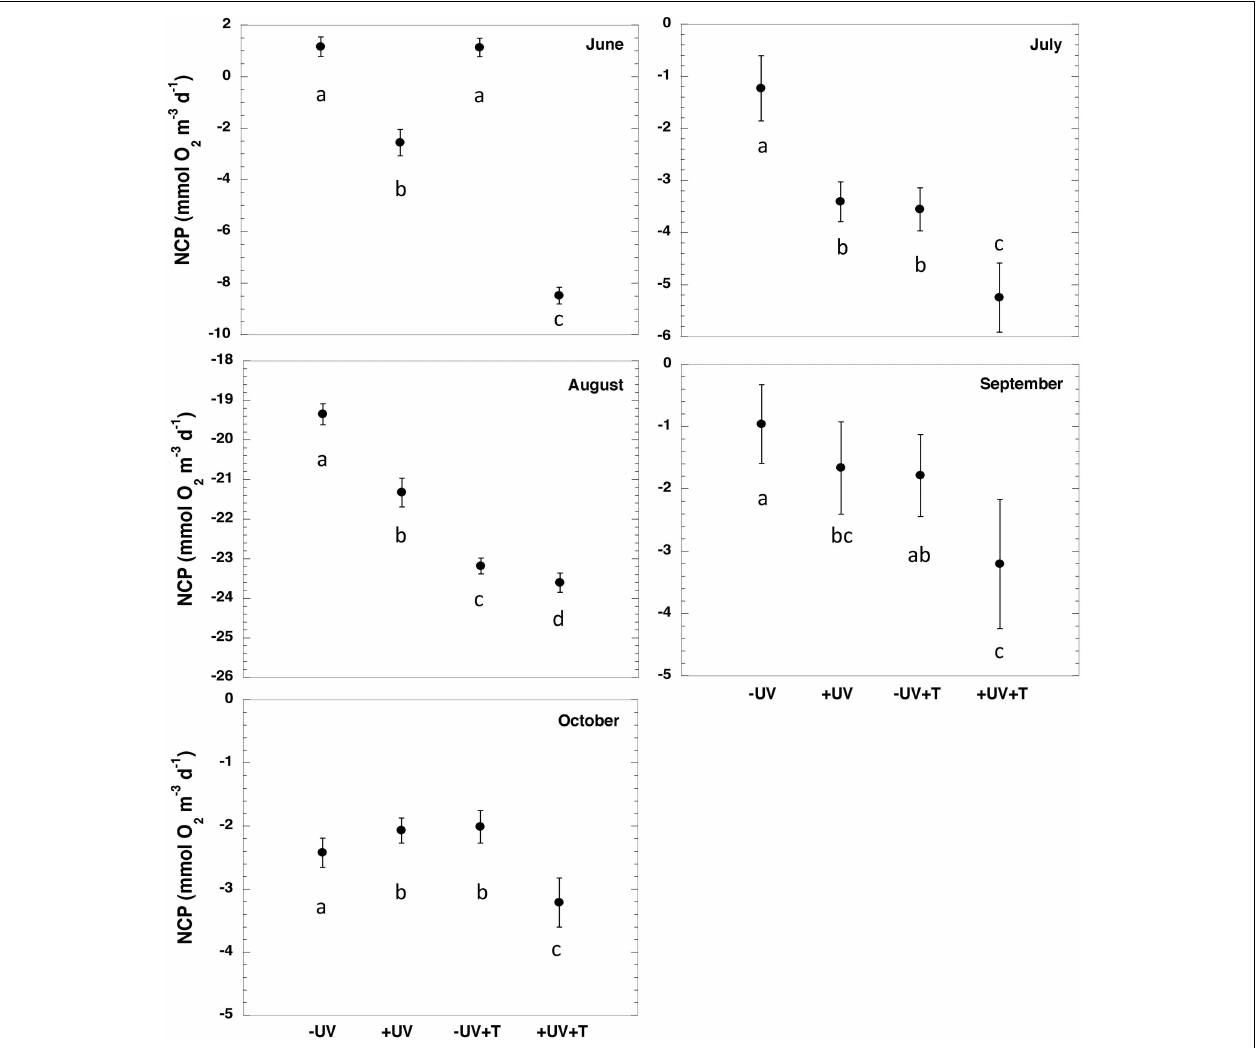
FIGURE 2 | NCP ± SE (mmol O 2 m − 3 d − 1 ) for the different treatments evaluated ( − UV, + UV, − UV + T, + UV + T) for each sampled month. Letters indicate the results of the ANOVA and post-hoc Tukey HSD test where levels not connected by the same letter are significantly different.